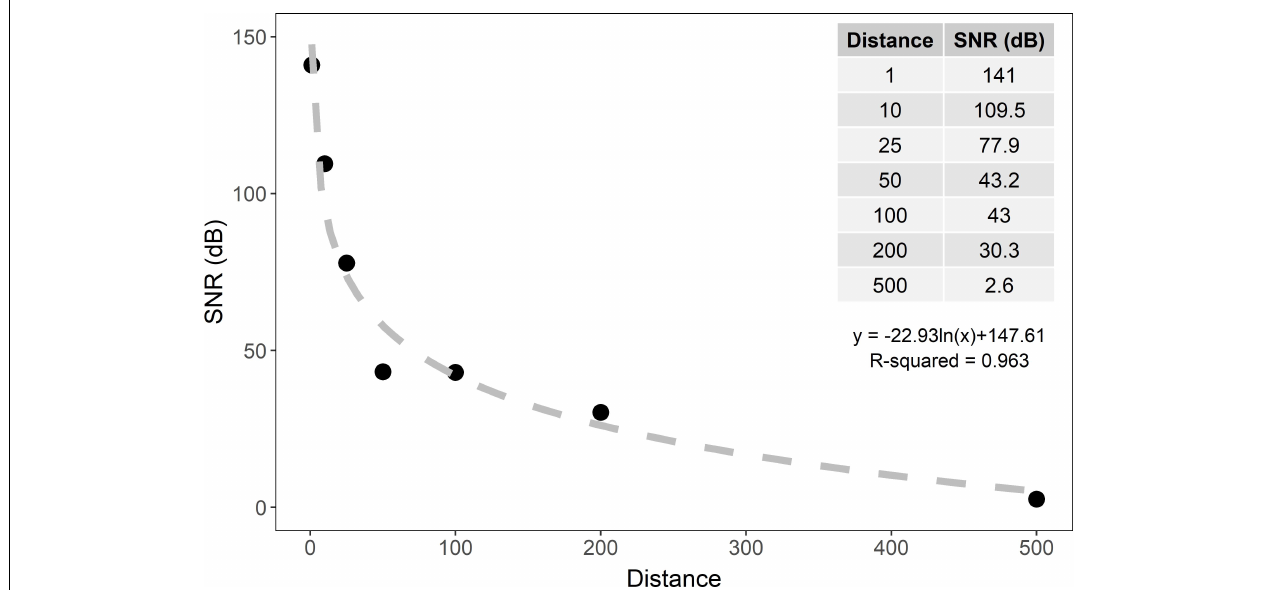
FIGURE 4 | Signal to noise ratio (SNR) and regression line of pure tones broadcasted at maximum volume in degraded hardbottom calculated from hydrophone recordings taken at seven distances (1, 10, 25, 50, 100, 200, and 500 m) from the playback device. At 500 m from the playback device, the signal is nearly undetectable from the background noise (SNR = 2.6